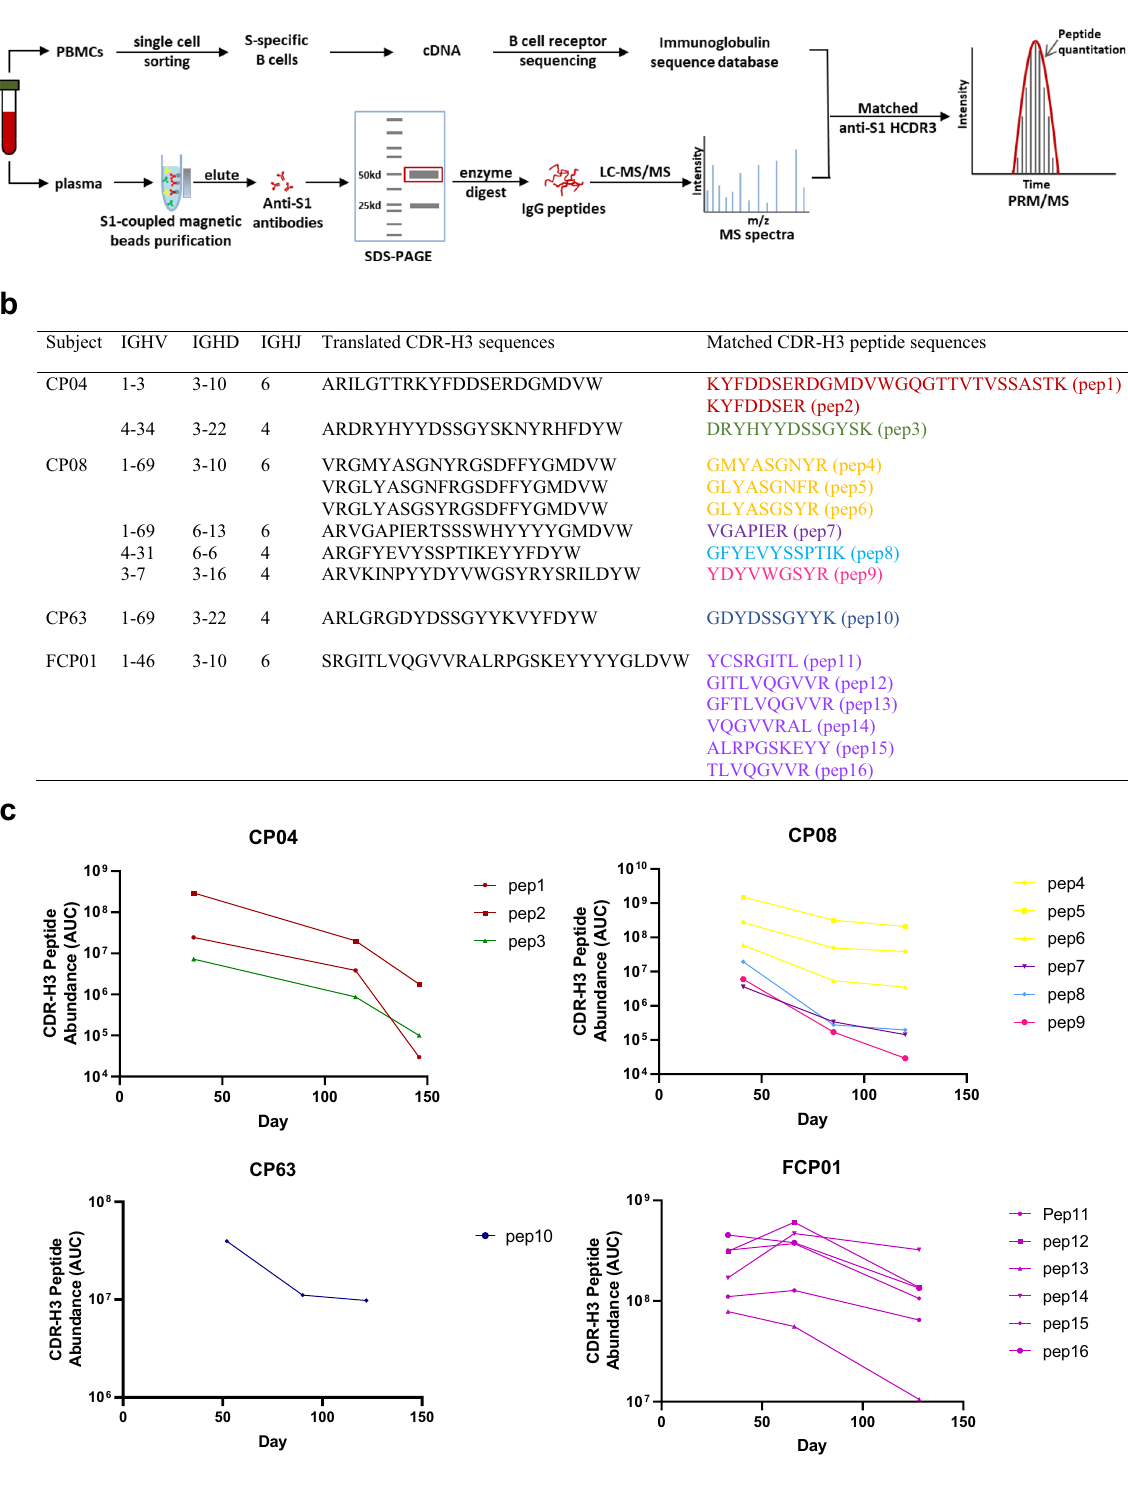
vaccines 30 – 32 . Given the relatively low level of somatic mutation to 843 days, with IgG + RBD-speci fi c cells MBC broadly com- parable (doubling time = 58 days early, t 1/2 = 247 days late; observed in S-speci fi c antibodies recovered from convalescent participants to date 6,19 comparative studies at 6-9 months post- Supplementary Fig. 7). The consistent and sustained increase in infection will be informative to understand the maturation of the S-speci fi c IgG + MBC frequencies over time aligns with a prior humoral response over time and the protective potential of stably report of SARS-CoV-2 convalescent participants 13 , and with retained MBC populations. reports from other viral infections 30 or replicating viral NATURE COMMUNICATIONS| (2021) 12:1162